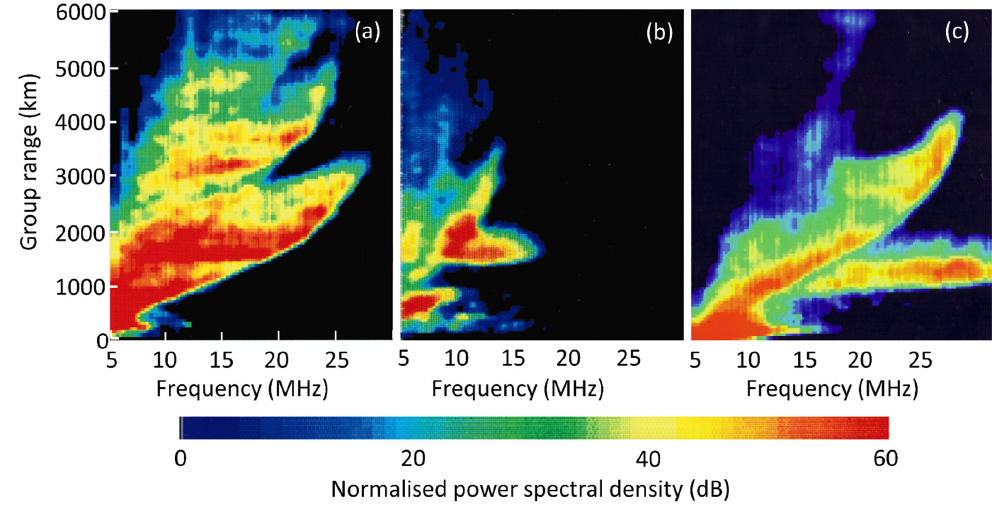
Figure 3. Examples of backscatter ionograms at different times of day and in different directions, illustrating the fundamental challenge of skywave radar: illuminating the area of interest with a suitable frequency. ( a ) Recorded at 1900 LT in direction 1; ( b ) recorded six hours later, at 0100 LT, in direction 1; ( c ) recorded at 1900 LT in direction 2.